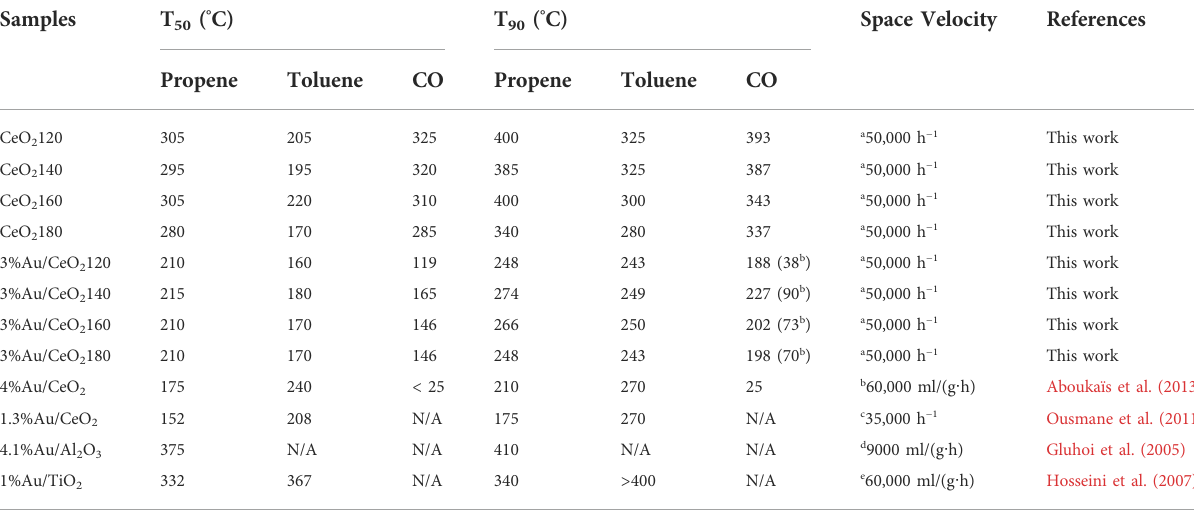
TABLE 4 Reaction temperatures corresponding to 50% (T 50 ) and 90% (T 90 ) substrate conversion catalyzed by the CeO 2 X supports and Au/CeO 2 X catalysts in the oxidation of the propene/toluene/CO gas mixture. Samples T 50 ( ° C) T 90 ( ° C) Space